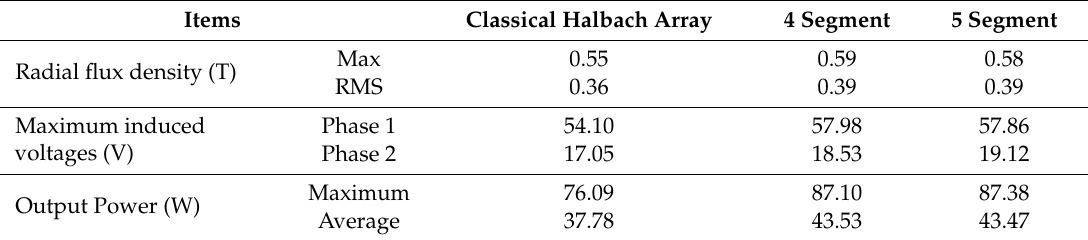
Figure 11. Comparison of: ( a ) 4-segment Halbach array; ( b ) 5-segment Halbach array. Table 3. Comparison of three models.